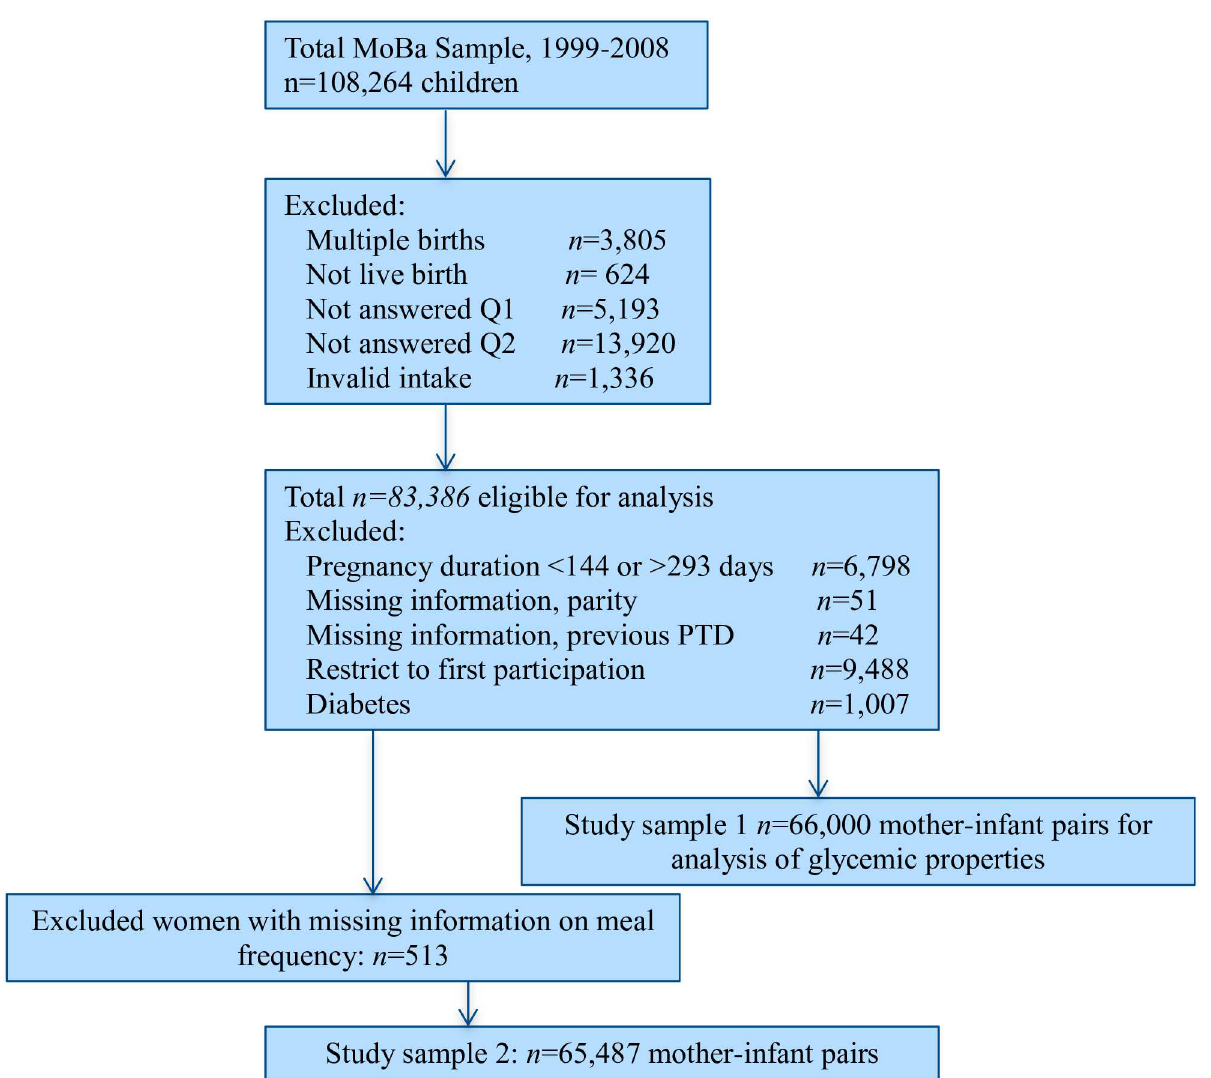
Fig 1. Flow chart showing selection of study participants. Q1 denotes the first prenatalquestionnaire, Q2 denotesthe MoBa food frequency questionnaire used from 2002.